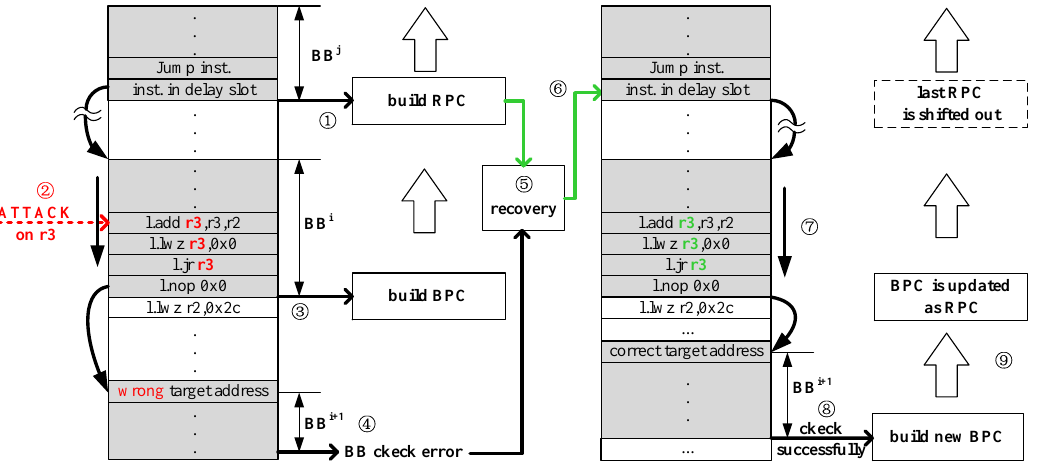
Figure 8. The principle of two stage BB-oriented backup and recovery